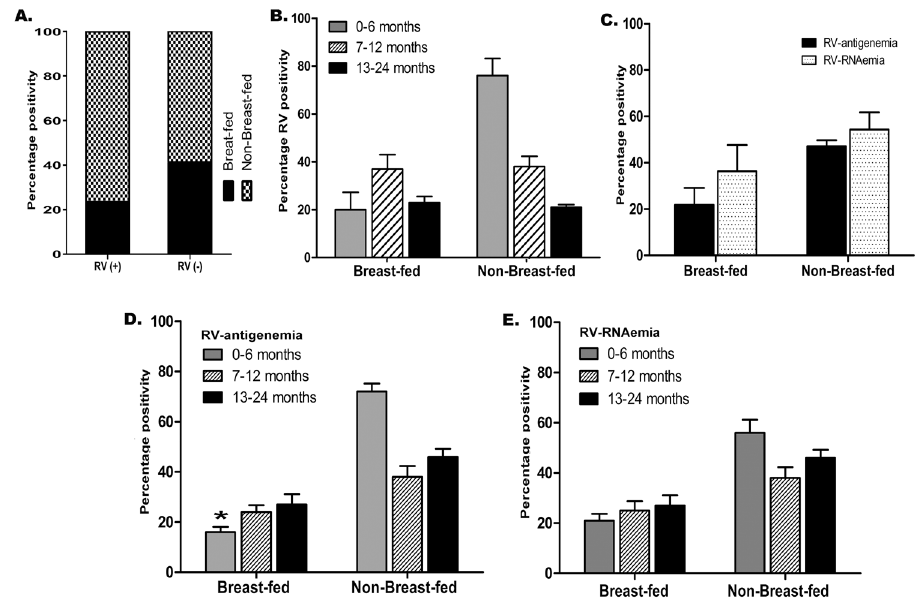
Fig 2. Relation of breast feeding status with Rotavirus infection and related outcome. (A) Breast- feeding wise distribution of Rotavirus positivity among all patients. (B, D-E) Age stratified data among breastfed and non-breastfed infants for Rotavirus positivity (B), Rotavirus antigenemia (D), and Rotavirus RNAemia (E). (C) Percentage positivity for Rotavirus antigenemia and Rotavirus RNAemia among breastfed and non-breastfed infants of the